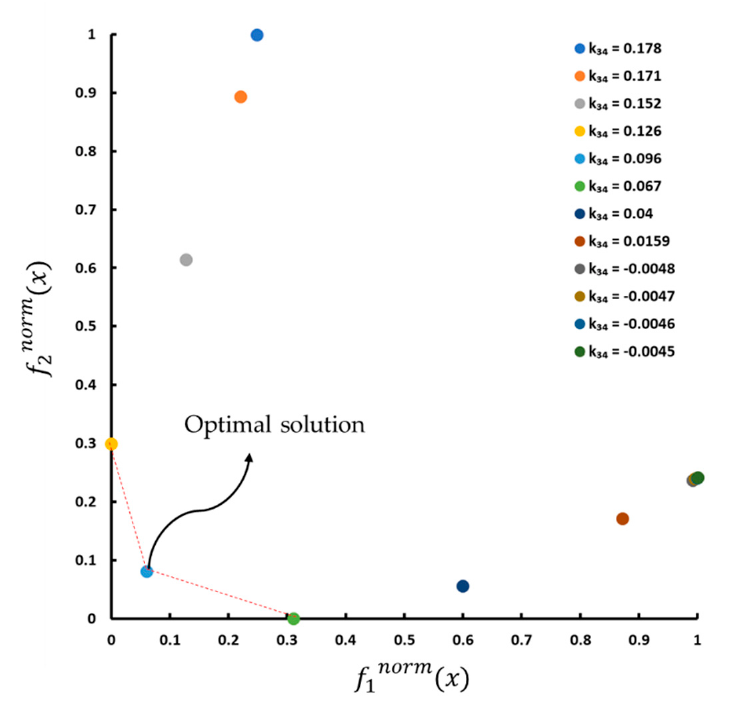
Figure 8. Graphical representation of two-objective optimization problem.